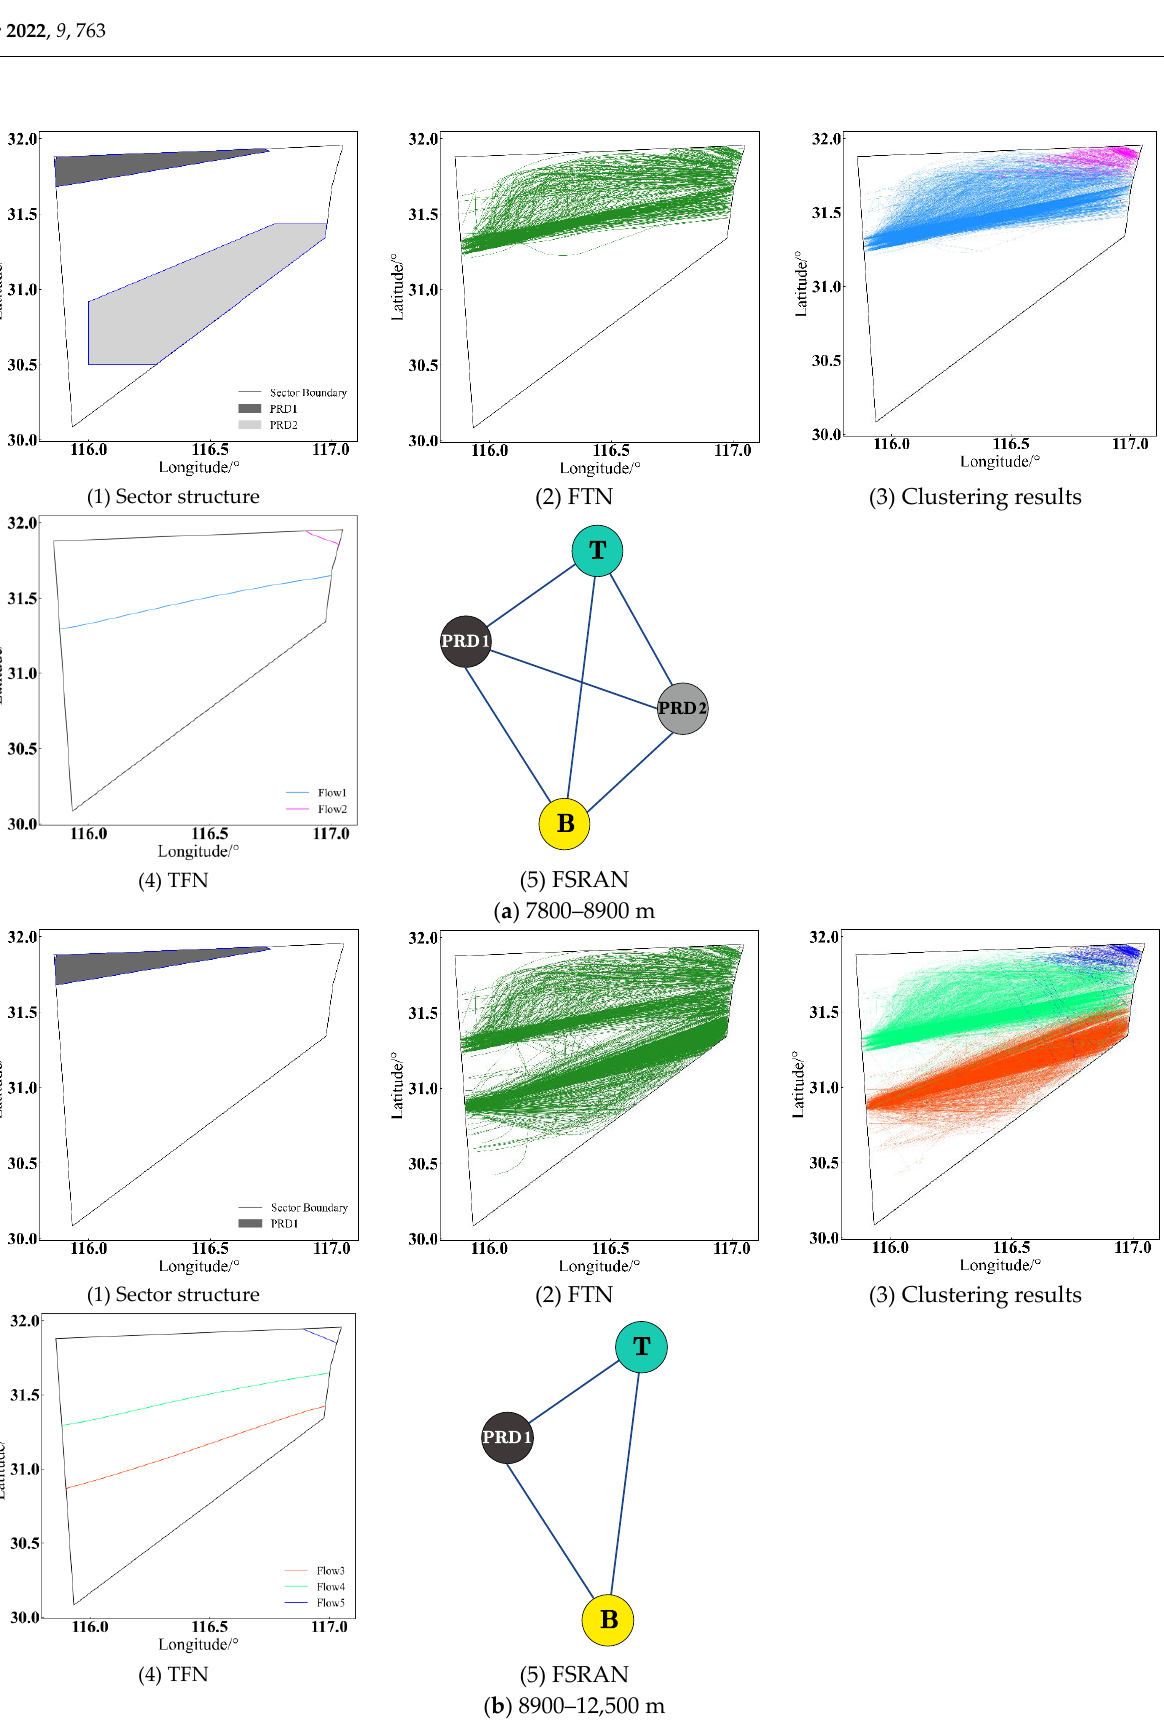
Figure 7. “Structure-flow” multi-layer network model of control sector